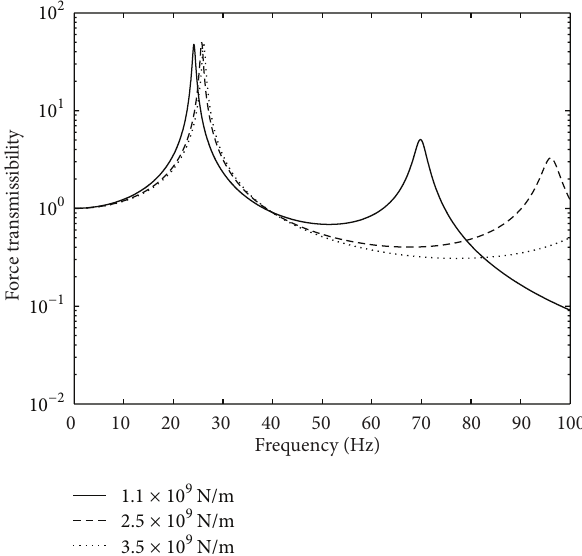
Figure 14: Dynamic force acting on propeller, oil film, and hull.